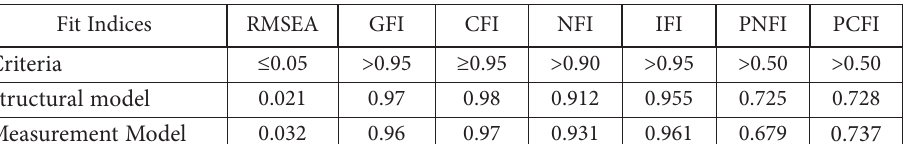
Table 5. Model fit